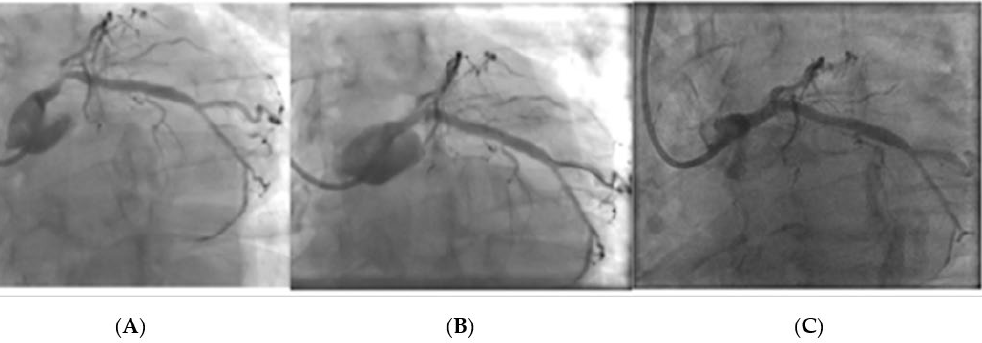
Figure 8. Left main stem PCI with DCB- Image ( A ): Pre PCI, Image ( B ): Immediately post-PCI, Image ( C ): 6-month follow-up angiogram.